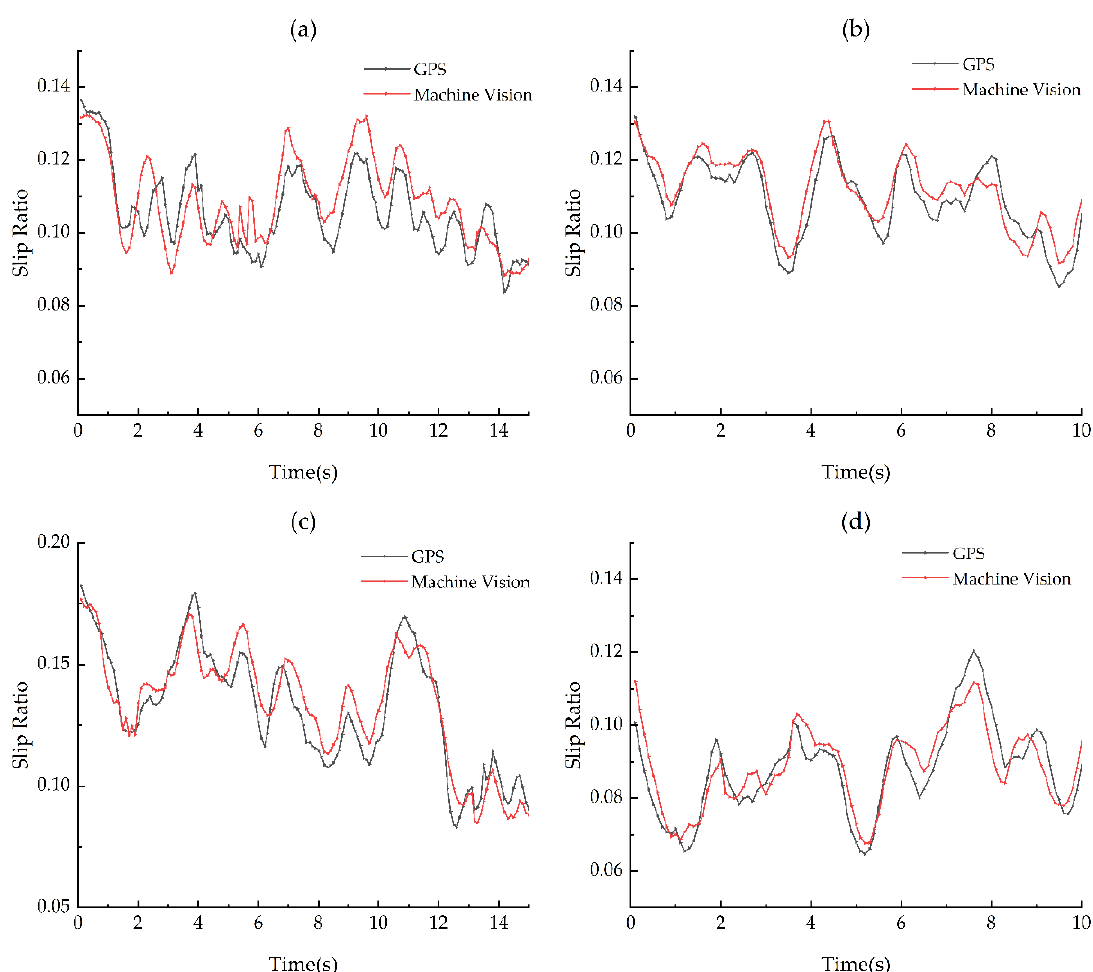
Figure 10. The results of the slip ratio for tractor driving wheels on the soft soil ground, where ( a ) is under the working condition of low velocity and low tire inflation pressure, ( b ) is under the working condition of high velocity and low tire inflation pressure, ( c ) is under the working condition of low velocity and high tire inflation pressure, ( d ) is under the working condition of high velocity and high tire inflation pressure.